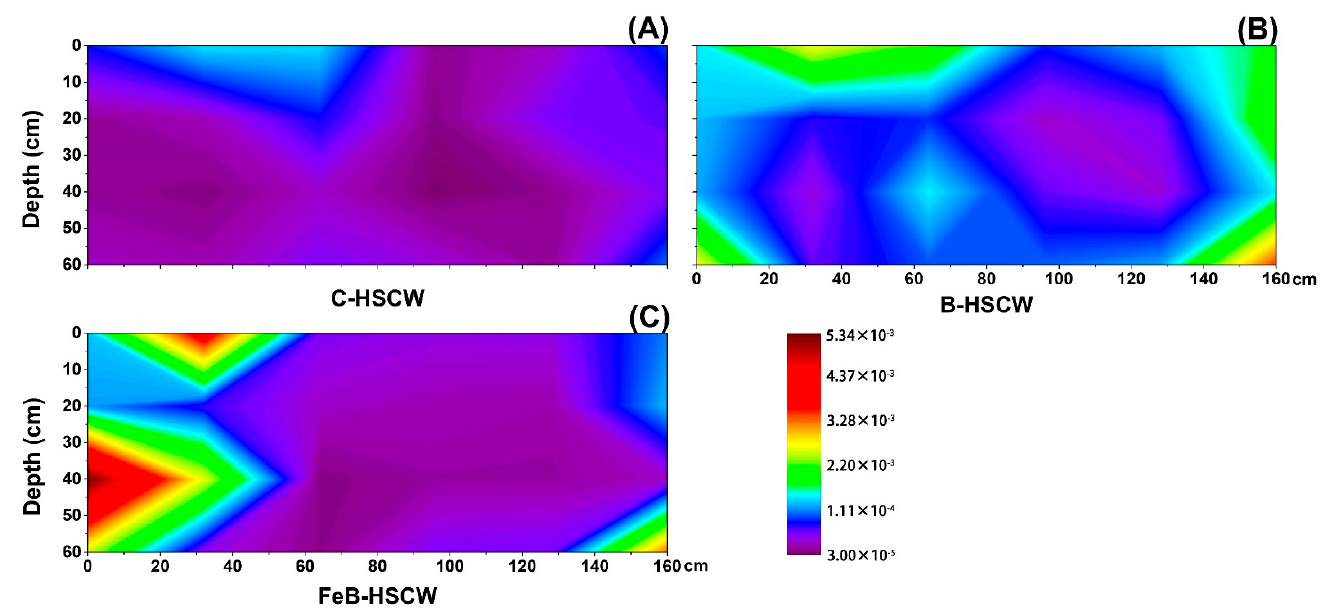
Figure 4. The spatial distribution of narG relative abundance in C-HSCW ( A ), B-HSCW ( B ), and FeB-HSCW ( C ) based on interpolated maps. Color scales indicate extrapolated values by kriging. C-HSCW, without biochar and FeB-modified biochar; B-HSCW, with biochar; FeB-HSCW, with FeB-modified biochar.